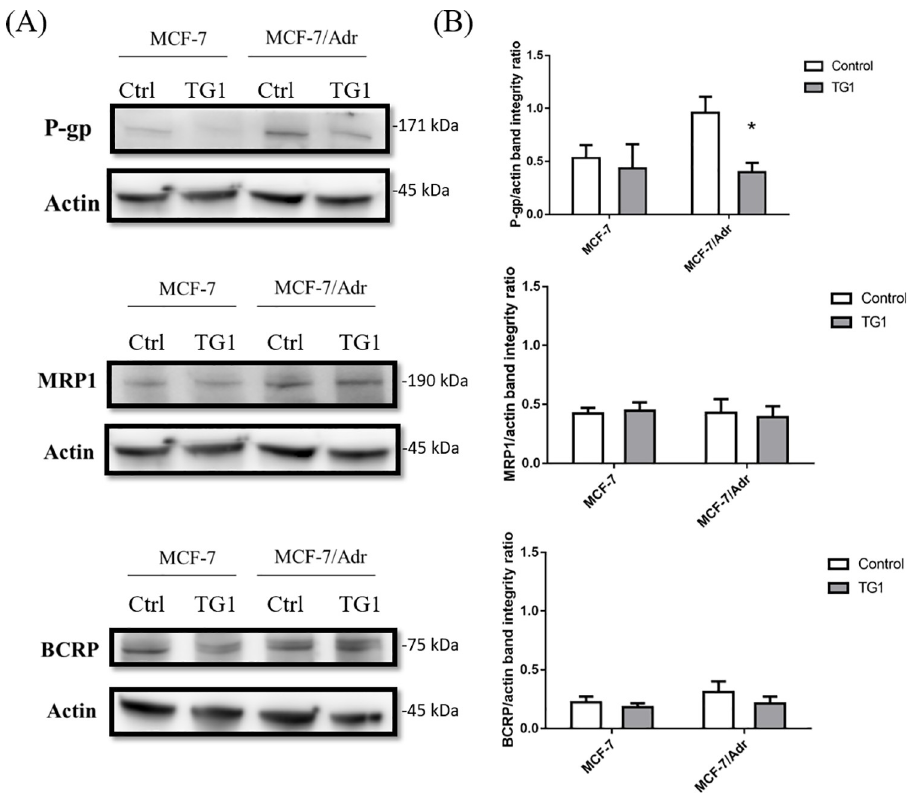
Fig 8. Effect of TG1 on expression of MDR related transporter in MCF or MCF-7/Adr cells. (A) Expression of P- gp, MRP1 and BCRP using western blot on MCF-7 or MCF-7/Adr cells. (B) Quantitative data are shown as mean ± SD, n = 3. � p < 0.01, which indicates significant differences between the experimental and control groups.